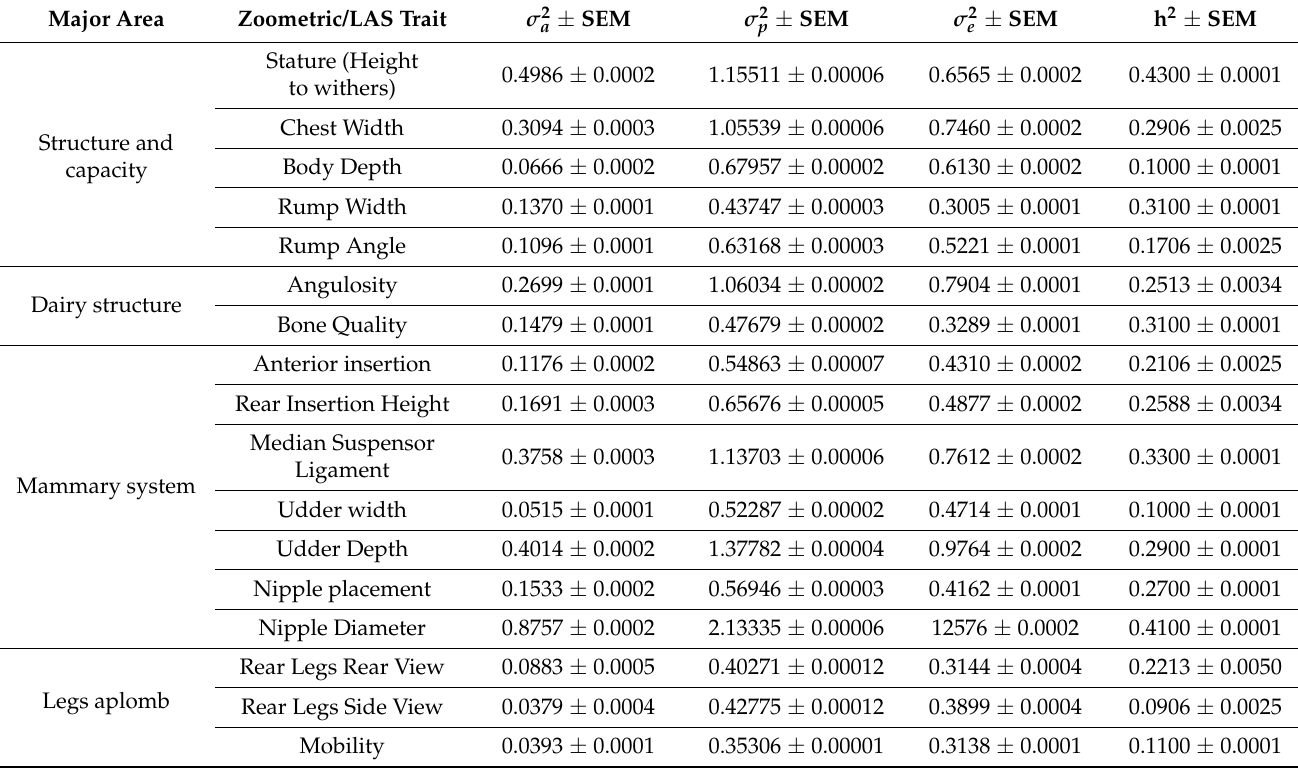
Table 4. Estimated components of variance, heritability (h 2 ) and standard error of the mean (SEM) for zoometric and LAS traits obtained from multivariate analyses through REML